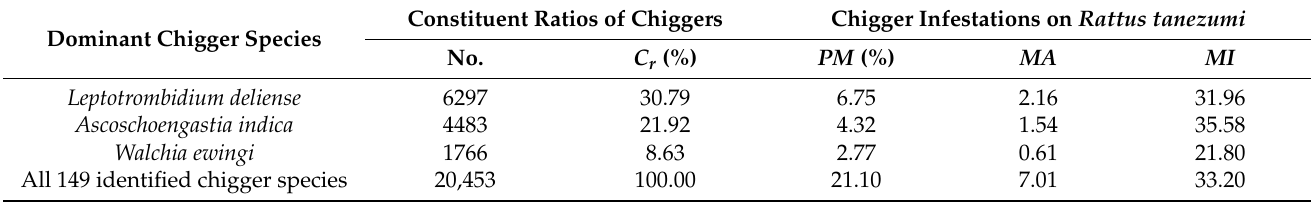
Table 1. Infestations of three dominant chigger species on oriental house rats ( Rattus tanezumi ) sampled between 2001 and 2019 in 5 provincial regions of Southwest